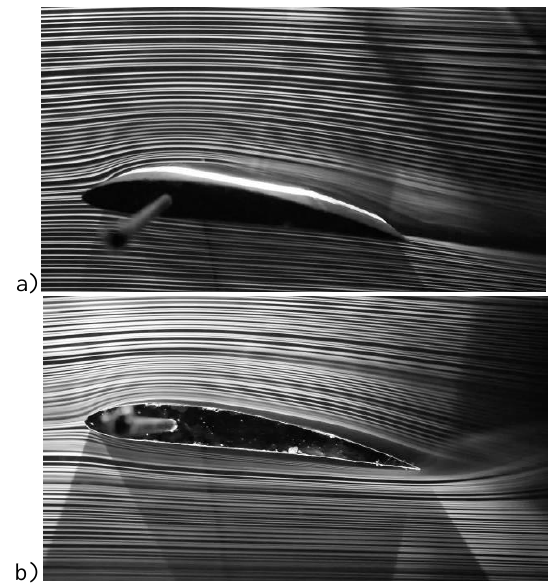
Fig . 5. At α=8º, smoke-wire photos for partial flexible wing at the plane of a) z/s=0.4 b) z/s=0.1 .